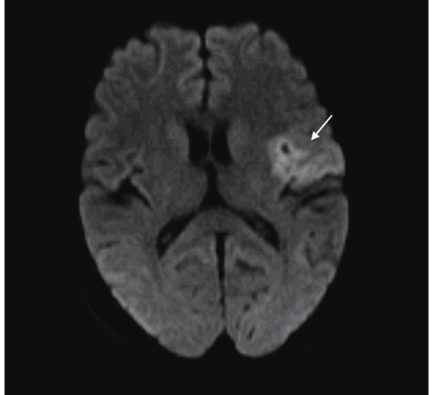
the normal. Electrocardiogram (ECG) revealed sinus rhythm. Figure 2: Axial diffusion MRI scan demonstrating high intensity lesion at the left frontal region consistent with acute infarction.